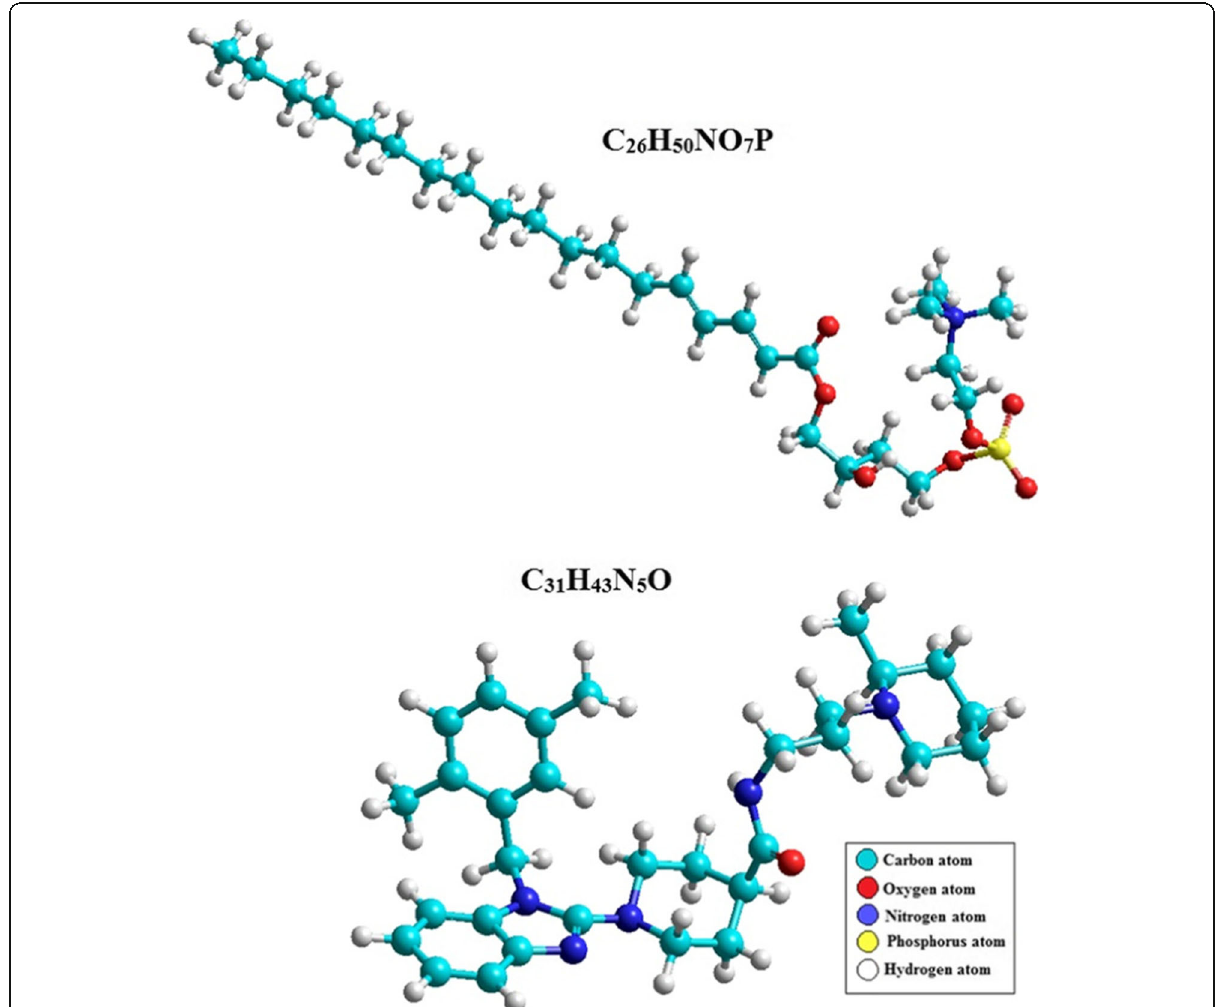
Fig. 15 Conformation structure for C 26 H 50 NO 7 P and C 31 H 43 N 5